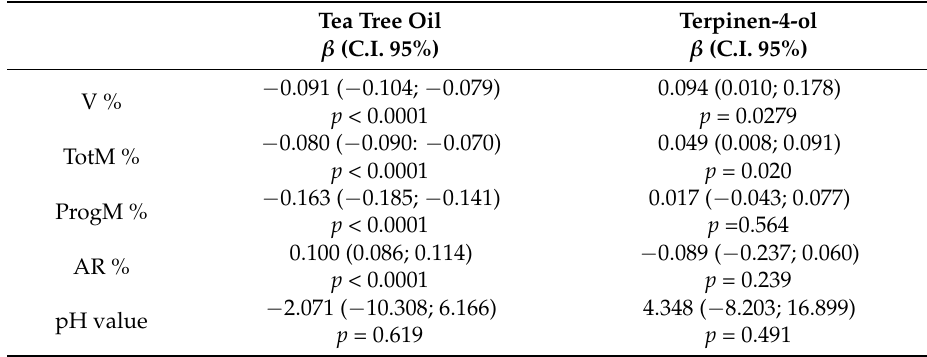
Table 4. Simple linear regression models’ angular coefficients ( β ). Tea Tree Oil